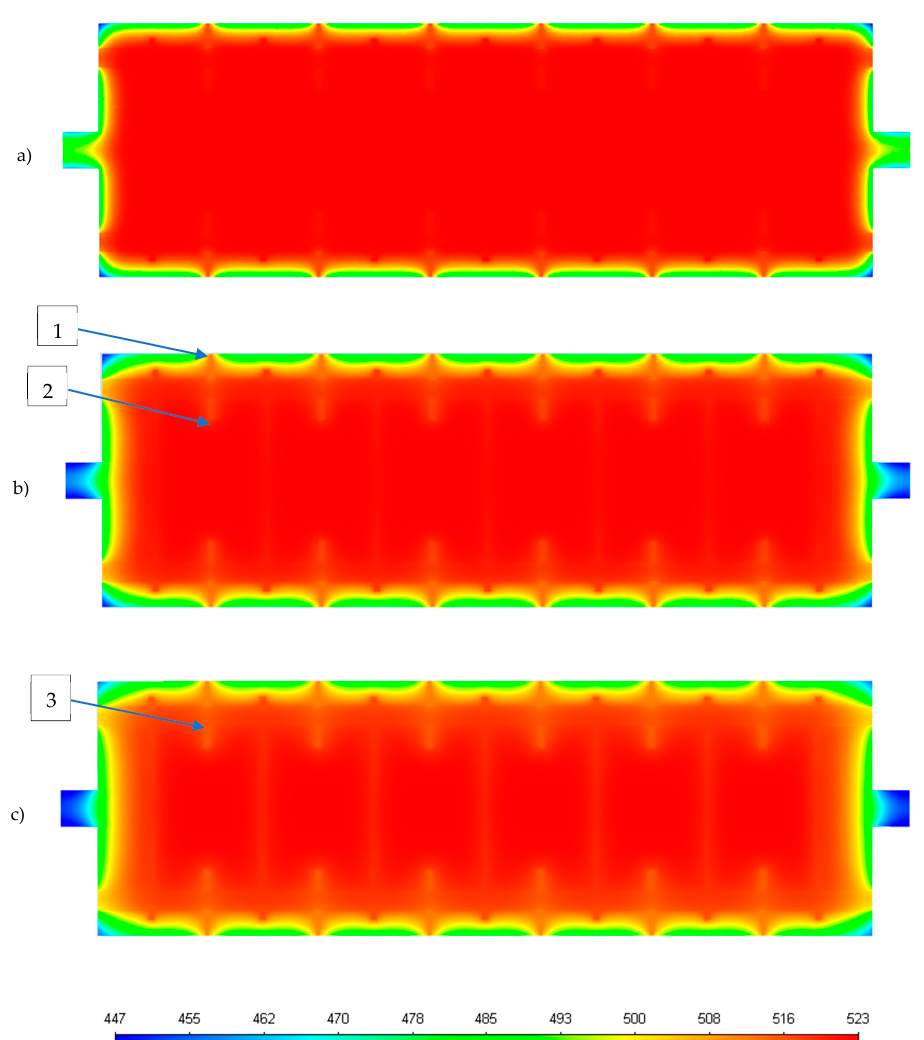
Figure 16. Reactor YZ plane temperature contours after ( a ) one, ( b ) three, and ( c ) five hours of no coolant/gas flow.